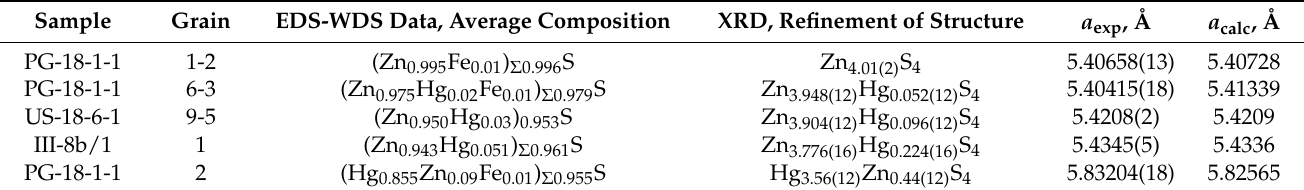
Table 9. Unit-cell metrics and composition of